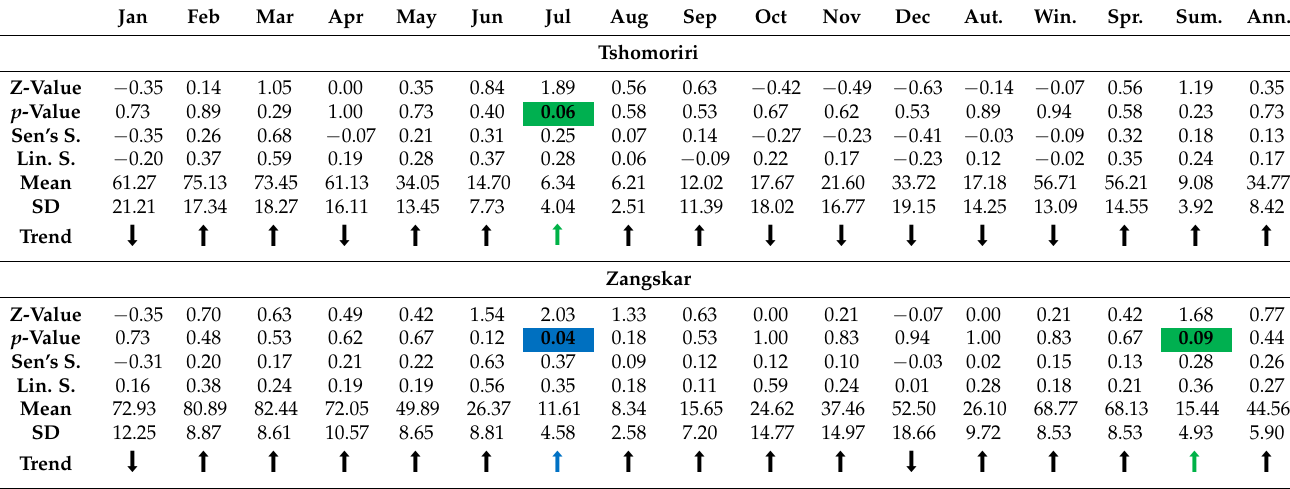
Numbers in bold and blue: significance level, p -value < 0.05.